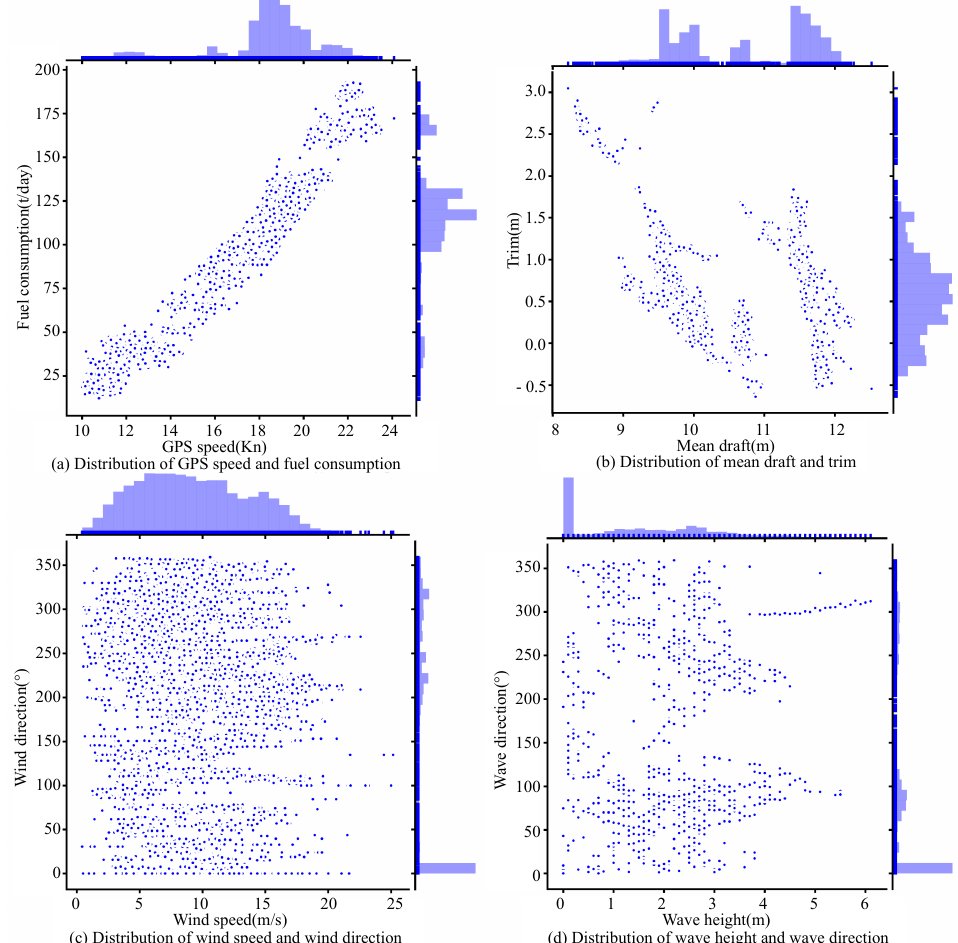
(d) Distribution of wave height and wave direction(c) Distribution of wind speed and wind direction